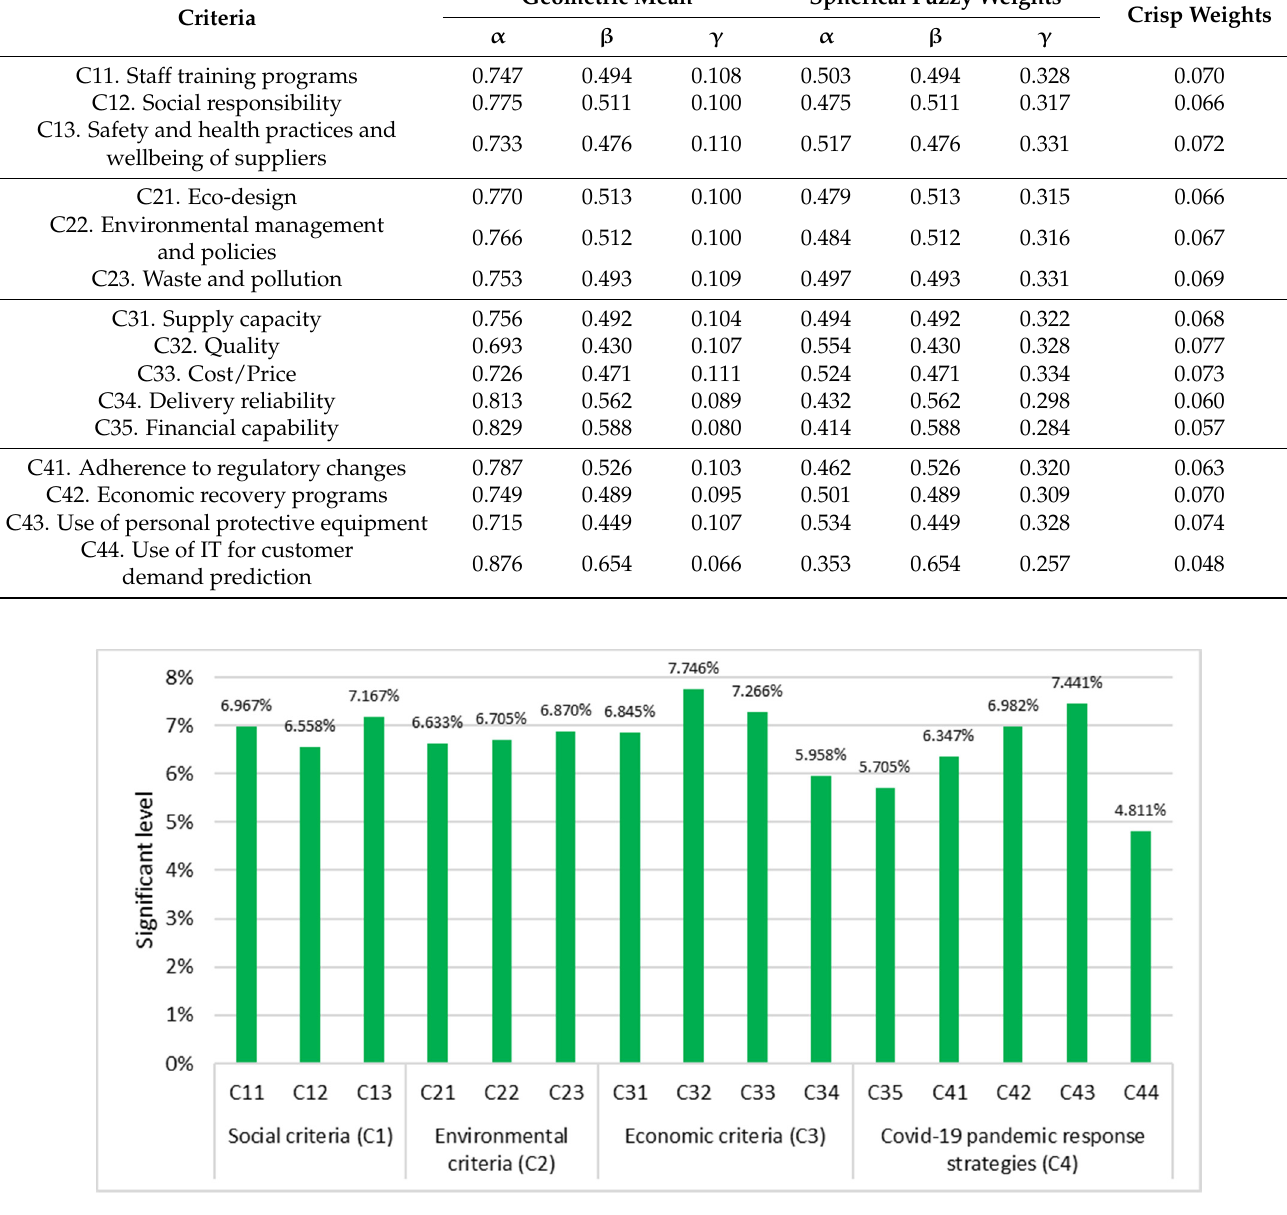
Figure 3. The significant level of 15 criteria of SF-AHP.